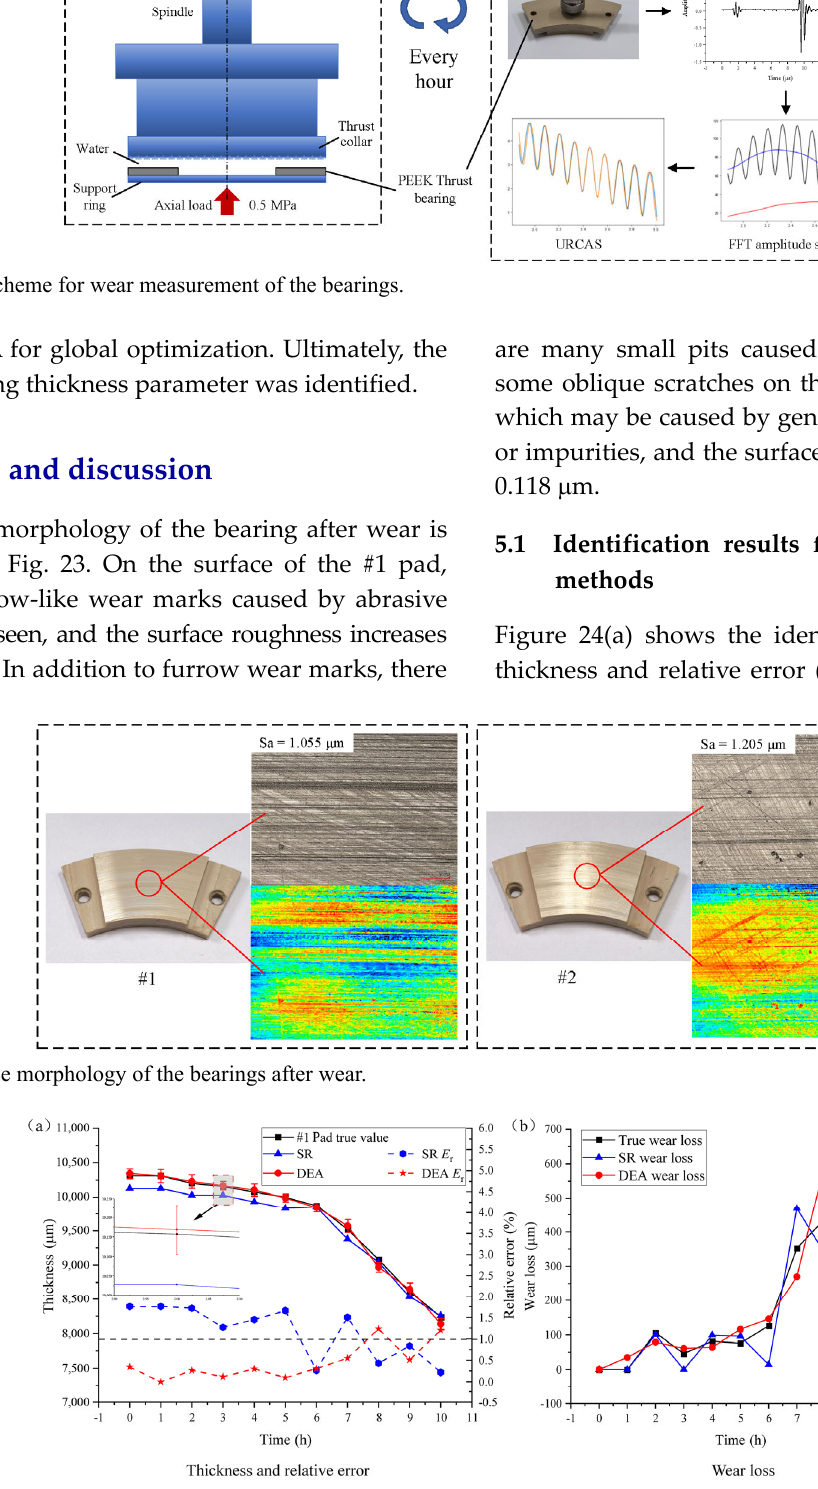
Fig. 24 Identification results of different ultrasonic methods of the #1